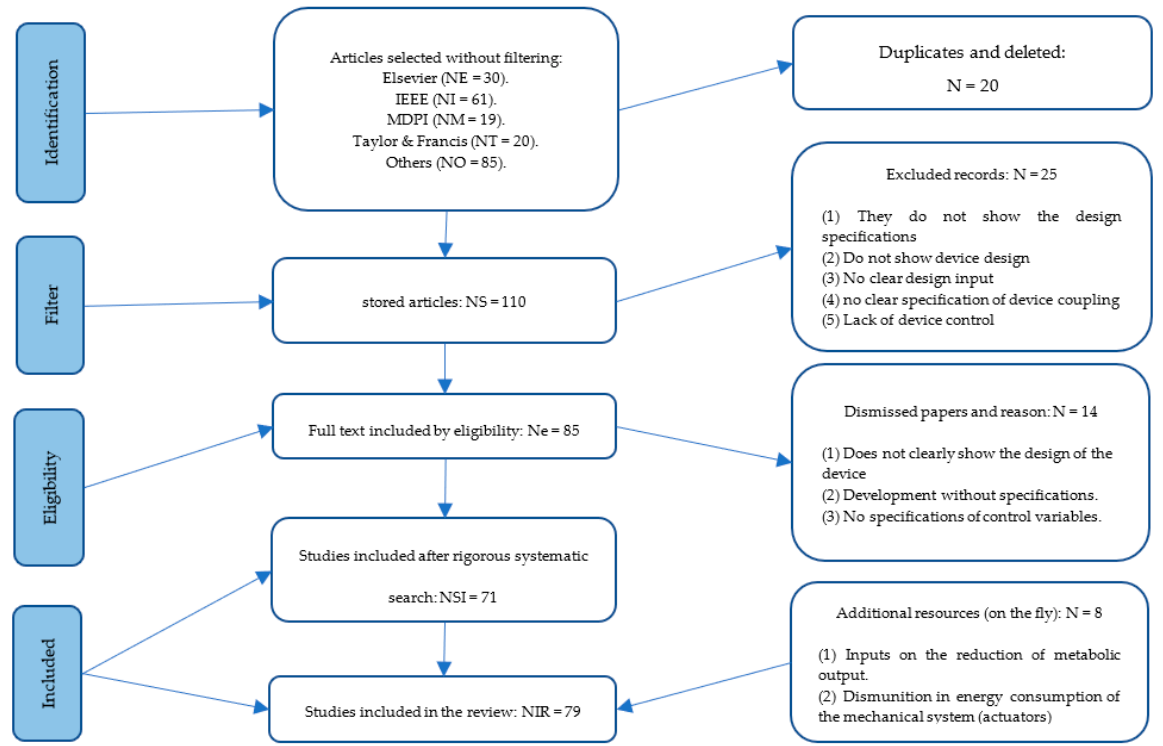
Figure 1. Diagram of the materials selection process.